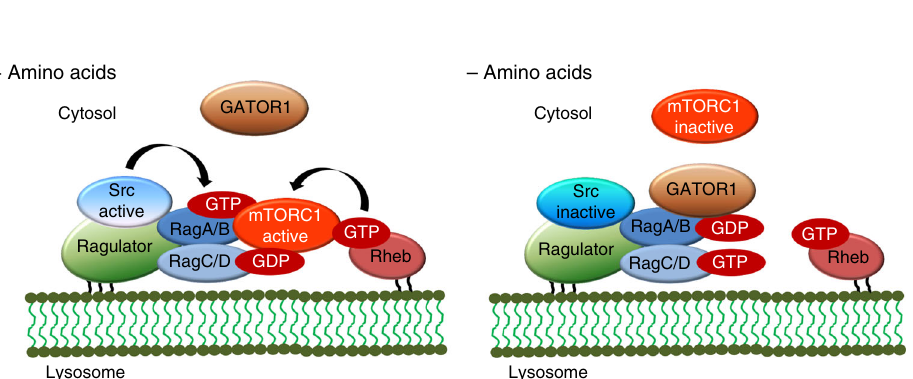
Fig. 7 Schematic diagram for Src-dependent regulation of mTORC1. The model shows that Src kinase regulates amino acid-mediated mTORC1 activity by controlling GATOR1 – Rag